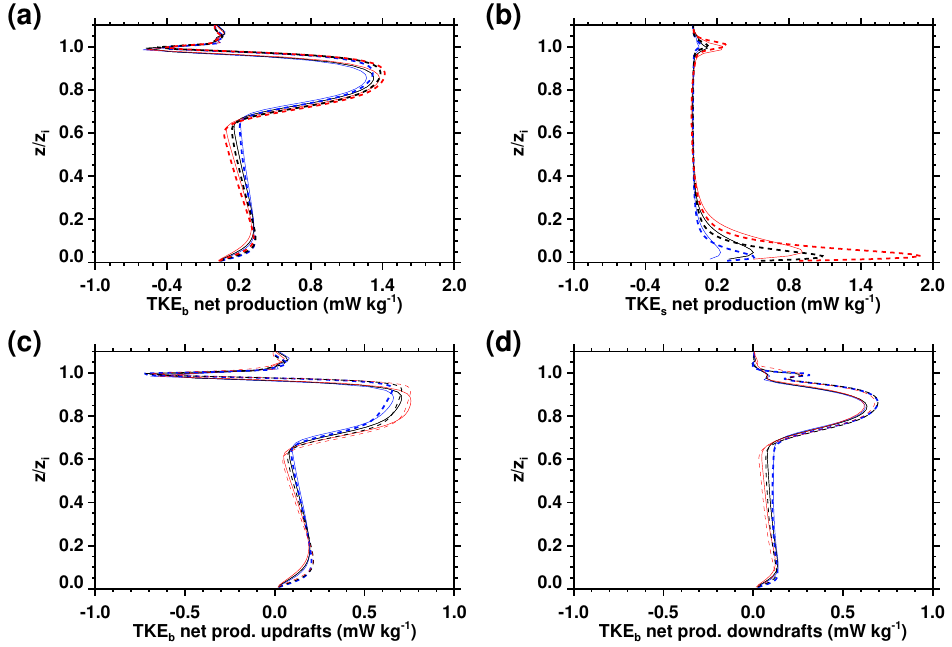
Figure C7. Effect of resolution. Profiles averaged over the period N (10:20–11:20UT) from simulations M − (blue), M 0 (black), M + (red), solid curves, and from simulations M − (blue), M 0 (black), M + (red), dashed curves. TKE b denotes buoyant production, TKE s fine fine fine shear production of turbulence kinetic energy. TKE b and TKE s in updrafts and downdrafts are air mass weighted sums over the updraft or downdraft locations at each level, respectively, normalized by the level air mass.